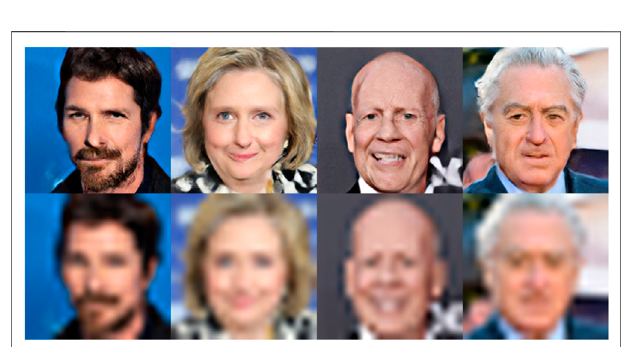
FIGURE 6 | SR (top) and interpolated (bottom) images of the celebrities that were recognized by less than half of the participants.